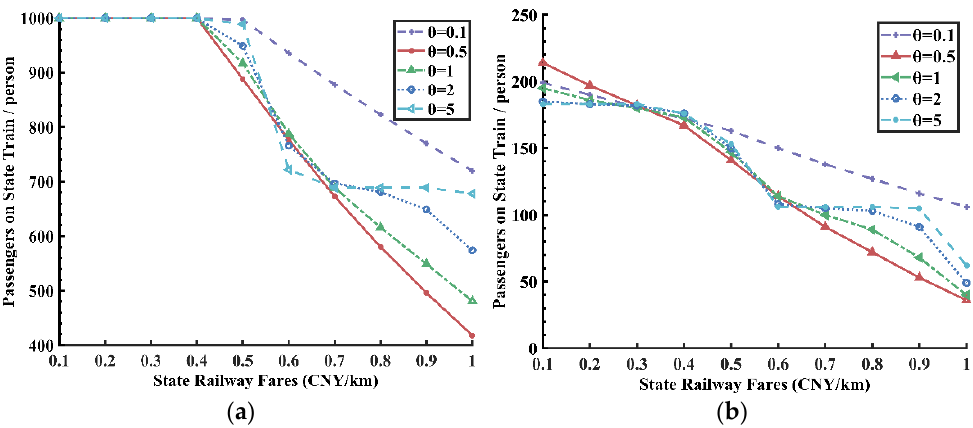
Figure 12. Sensitivity analysis of state railway fares to state train passengers. ( a ) Section between st.5 and st.8. ( b ) Section between st.8 and st.11.